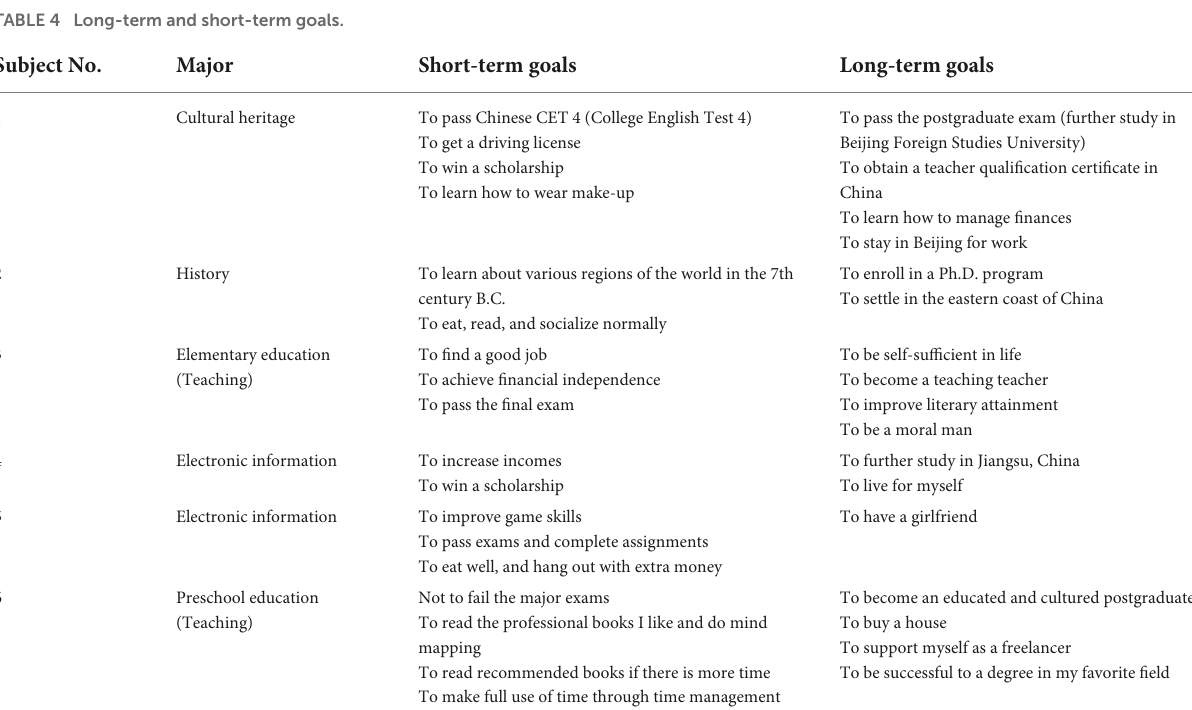
FIGURE1 Word cloud about life goal.